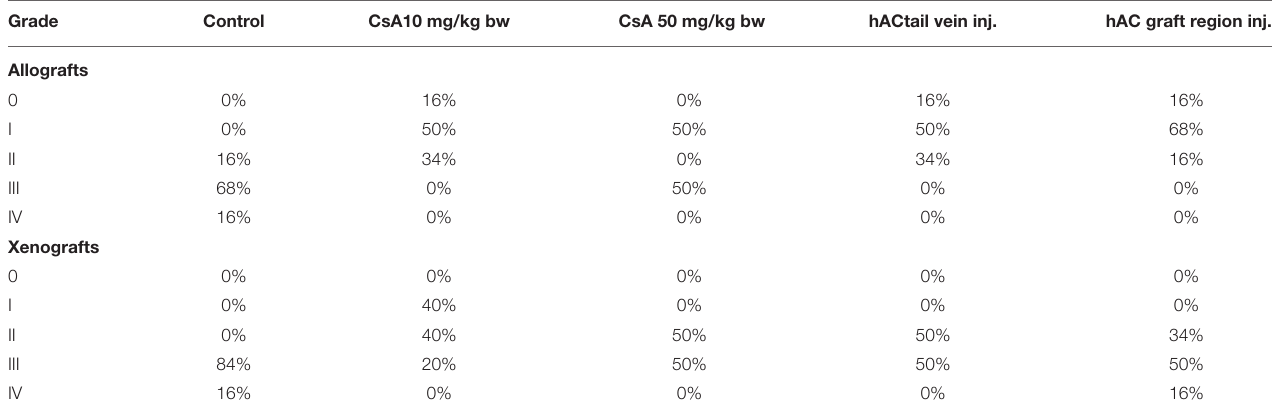
TABLE 4 | Percentage of individuals representing a specific stage of graft rejection (0–IV) in all studied groups of mice. Grade Control CsA10 mg/kg bw CsA 50 mg/kg bw hACtail vein inj. hAC graft region